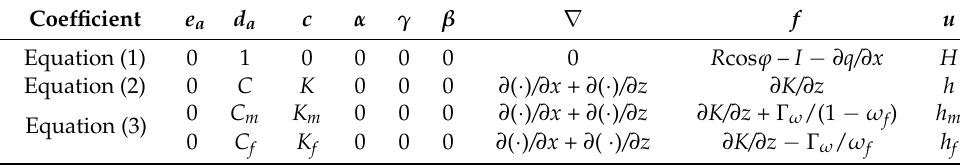
Table 1. Setting of coefficients and expressions in COMSOL PDE